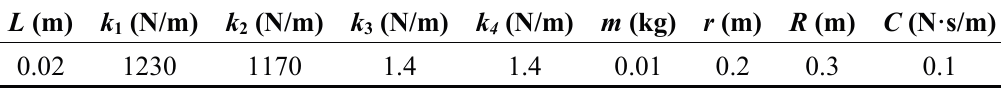
Table 2. Design parameters of the analytical model for low wheel